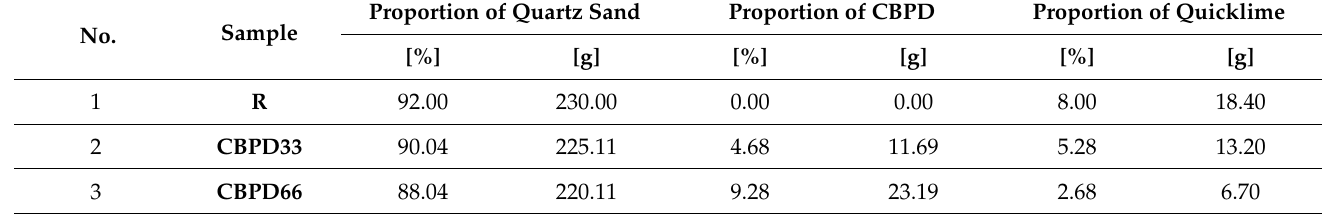
Table 2. Composition of mixtures with CBPD (at the moisture content of the mixture of 6–8%).